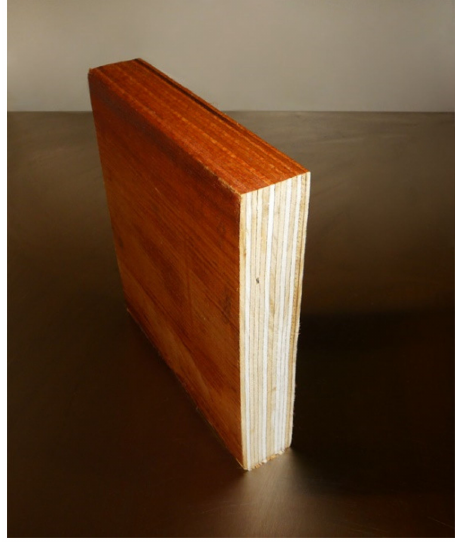
Figure 2. LVL (source: Wikipedia).